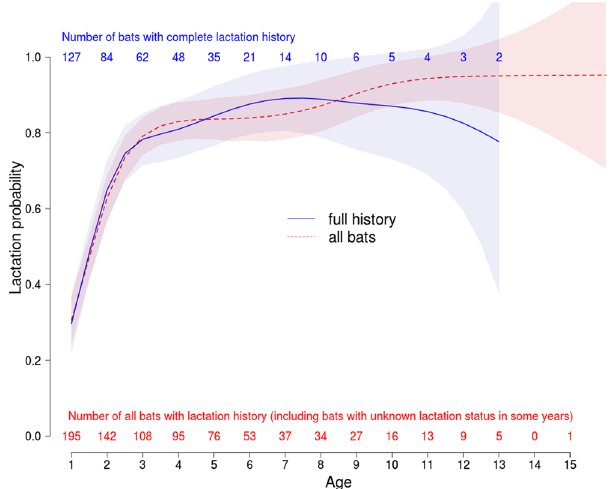
Figure 5. Age-specific fertility as the age-specific probability of lactation during the study period from 1996– 2014. The dashed line resembles all bats, including those with gaps in their fertility-history. The number of bats in each age class is shown below the curves in red (n all bats) or above the curve in blue (bats full history). The solid line shows the fit for all bats with a complete fertility-history and the corresponding number of individuals for each age class is given above the solid